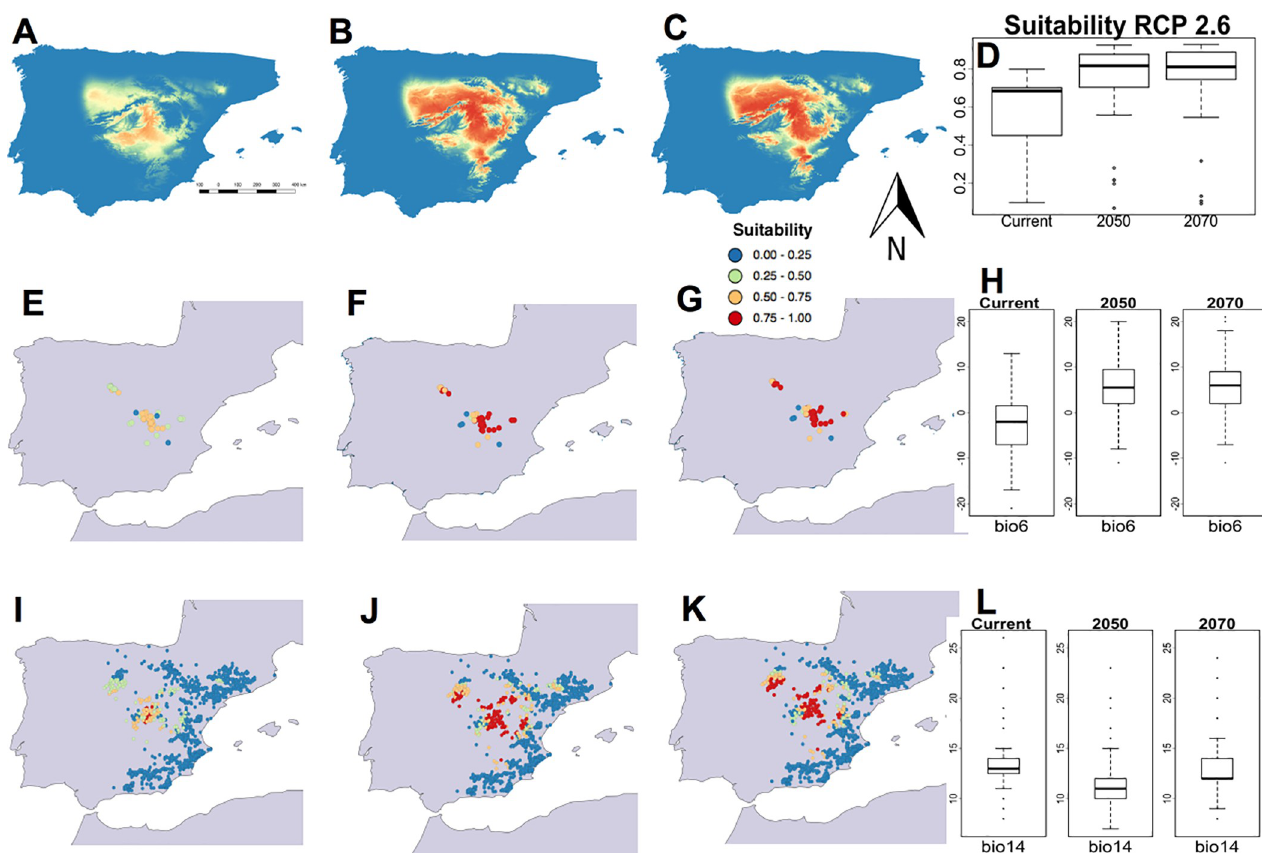
Fig 2. Habitat suitability predicted by the MaxEnt models for G . bermejoi under the RCP 2.6 scenario. Habitat suitability map for the current climatic conditions (A), those predicted for 2050 (B) and those for 2070 (C). (D) Habitat suitability values in the current climatic conditions (R software standard box- plot), and under those predicted for 2050 and 2070, measured at the sites where this taxon is currently found. In E, F and G, we show the bioclimatic suitability values for the sites where G . bermejoi is currently found. To aid interpretation of these maps, a color code was used to express the different intervals of habitat suitability. (H) These box-plots show the evolution of the values for the Bio 6 variable (the minimum temperature in the coldest month) measured at the sites where G . bermejoi is currently found. The bioclimatic suitability was also measured at each location with gypsum soil indicated by the presence of O . tridentata . These values are shown for the current climatic conditions, and the conditions predicted for 2050 and 2070, in maps I, J and K, respectively. (L) These box- plots are similar to those in (H) but for the values of the Bio 14 variable (precipitation in the driest month), also measured at the locations where G . bermejoi is currently found.